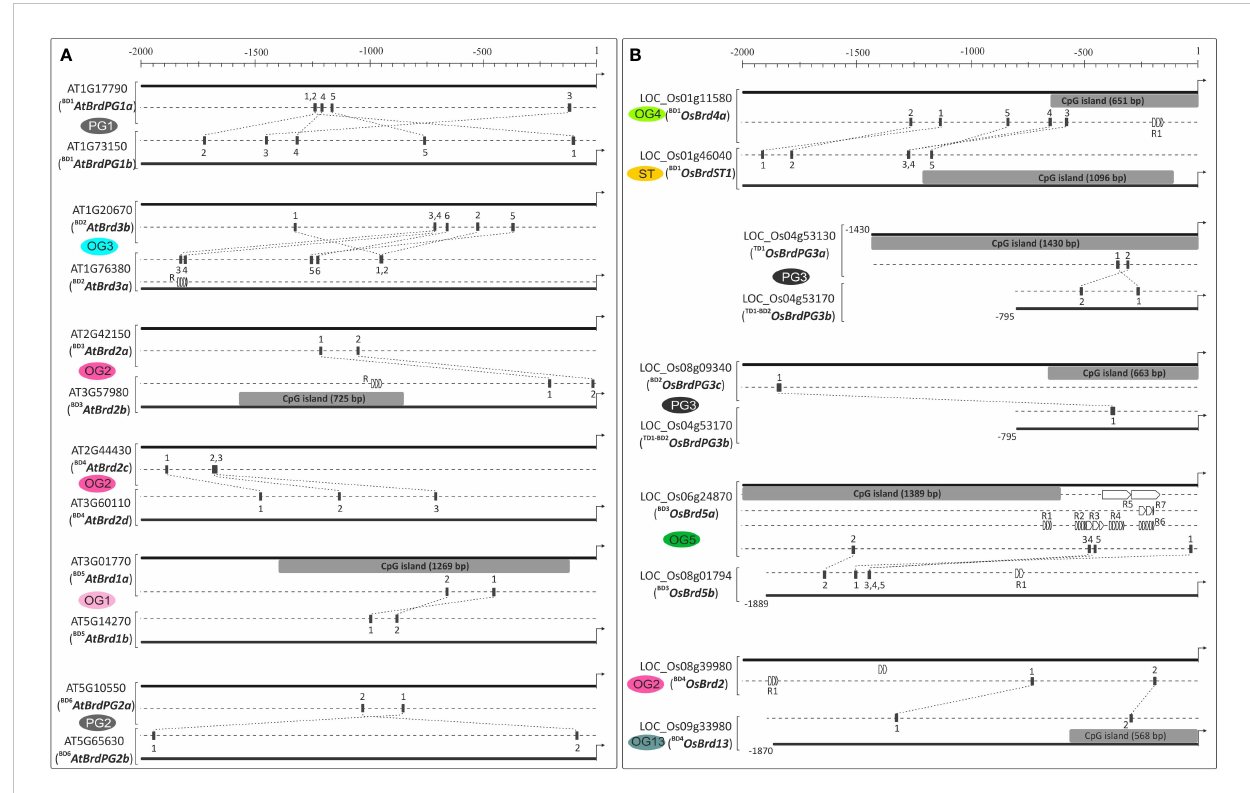
FIGURE 6 Analysis of upstream region (-2000 bp) of duplicated Brd -genes of A. thaliana (A) and O. sativa (B) on PlantPAN3.0 database, for difference in CpG islands (grey boxes), transcription factor binding sites (TFBS, indicated with numerals 1-6 in different genes) and repetitive motifs (R). The designation (and locus number) of Brd-members, association with ortholog group (OG)/paralog group (PG)/singleton category (ST) is indicated, and the designations ‘ BD ’ and ‘ TD ’ in the names indicate block or tandem duplication. Scale on the top indicates the length of upstream region (bp), arrow towards right indicates translation start